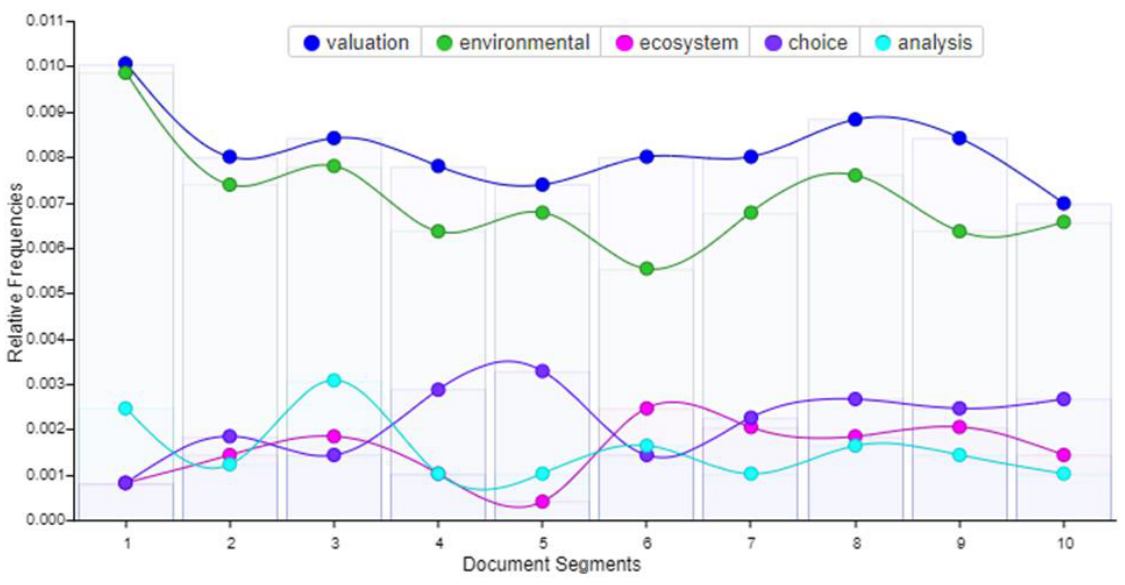
Figure 10. The word cloud of the author keywords related to environmental valuation using Voyant Tools.